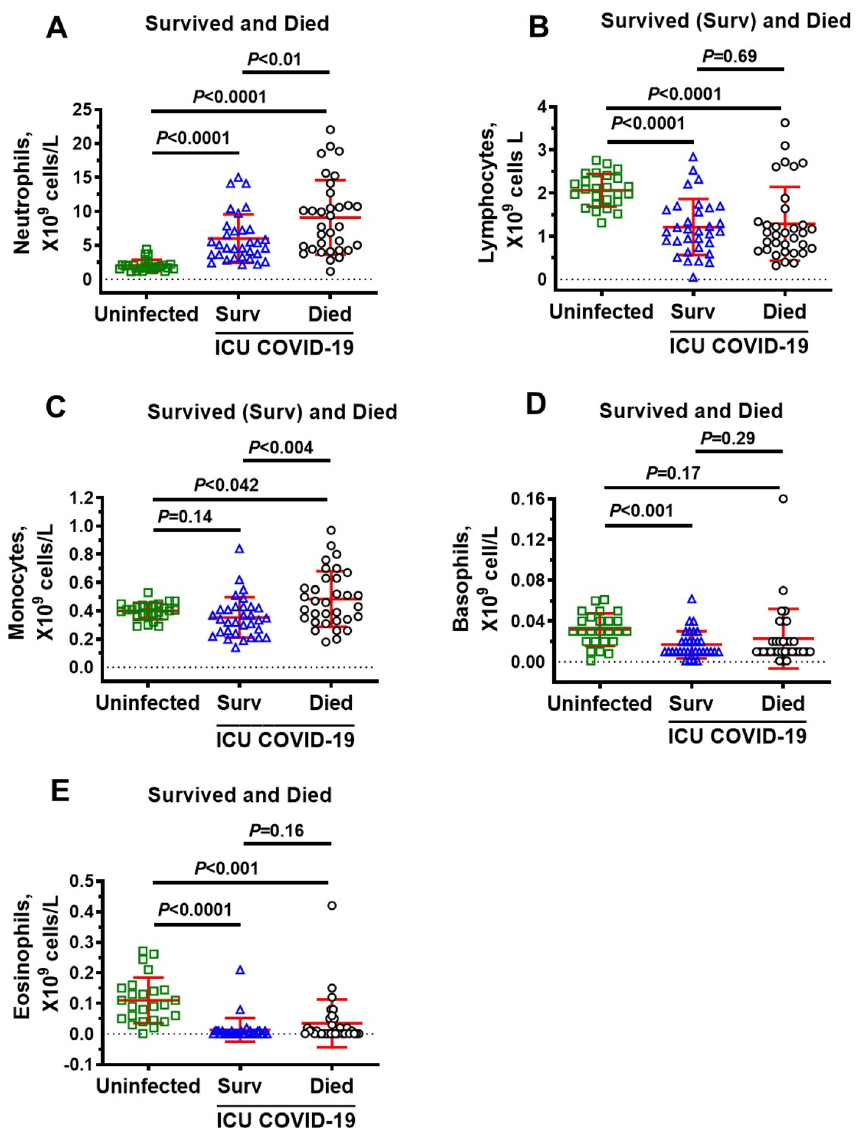
Figure 4. Plasma levels of neutrophils, lymphocytes, monocytes, basophils and eosinophils in uninfected non-DM individuals and ICU COVID-19 patients that survived and died. ( A ) Neutrophils levels in blood from ICU COVID-19 patients that survived and died were significantly higher than that in uninfected controls. Neutrophils levels in blood from ICU COVID-19 that died were also significantly higher than ICU COVID-19 patients that survived. ( B ) Lymphocytes in blood from ICU COVID-19 patients that survived and died were significantly lower than that in uninfected controls. However, there were no significant difference in blood levels of lymphocytes in ICU COVID-19 patients that survived and died. ( C ) Monocytes in blood from ICU COVID- 19 patients that survived were not significantly different from that in uninfected controls. However, monocytes levels in blood from ICU COVID-19 patients that died were significantly higher than that in uninfected controls and ICU COVID-19 patients that survived. ( D ) Basophils levels in blood from ICU COVID-19 patients that survived but not died were significantly higher than that in uninfected controls. There was no significant difference in blood basophils levels between ICU COVID-19 patients that died and survived. ( E ) Eosinophils levels in blood from ICU COVID-19 patients that survived and died were significantly higher than that in uninfected controls. However, there were no significant difference in blood levels of eosinophils in ICU COVID- 19 patients that survived and died. Data shown are mean ± S.E.M from n = 30 in uninfected controls (26.6% females), n = 33 died (42.4% females) and n = 32 in survived (37.5% females). Statistical significance levels are shown above data points on each